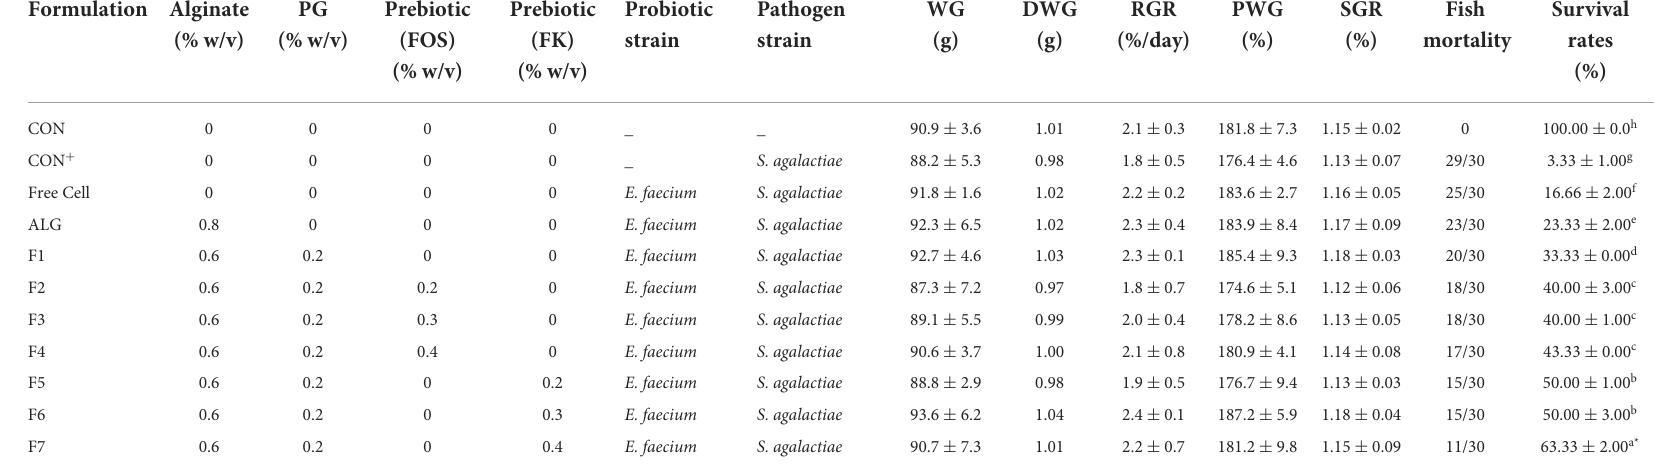
TABLE 4 Growth performance, mortality and survival rates of fish infected with Streptococcus agalactiae (1.6 × 10 8 CFU ml − 1 ) after 90 days of feeding with food pellets containing Enterococcus faecium microencapsulated with various gel and prebiotic concentrations. Formulation